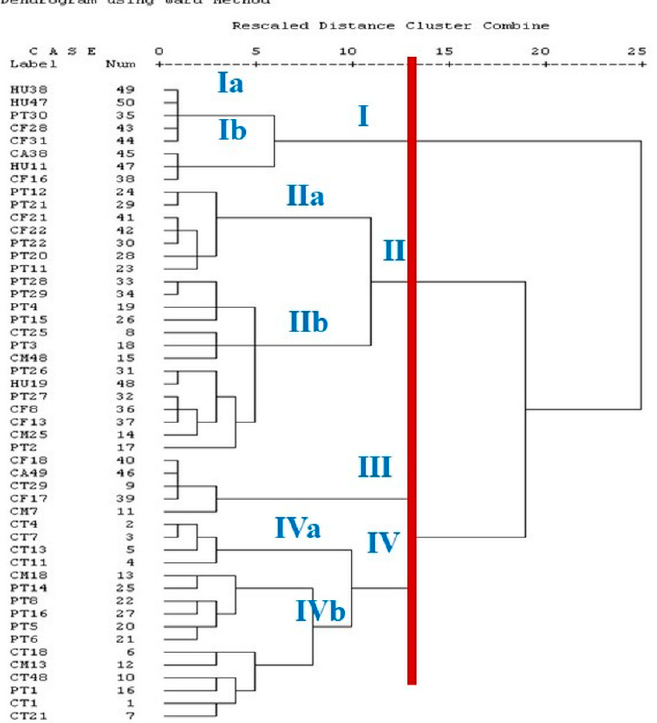
Figure 4. Dendrogram showing the relatedness of C. perfringens isolated from different sources as determined by RAPD-PCR fingerprinting using the SPSS computer software program. (CT: chicken intestine, CM: chicken meat, PT: pigeon intestine, CF: camel feces, CA: camel meat, HU: human stool).